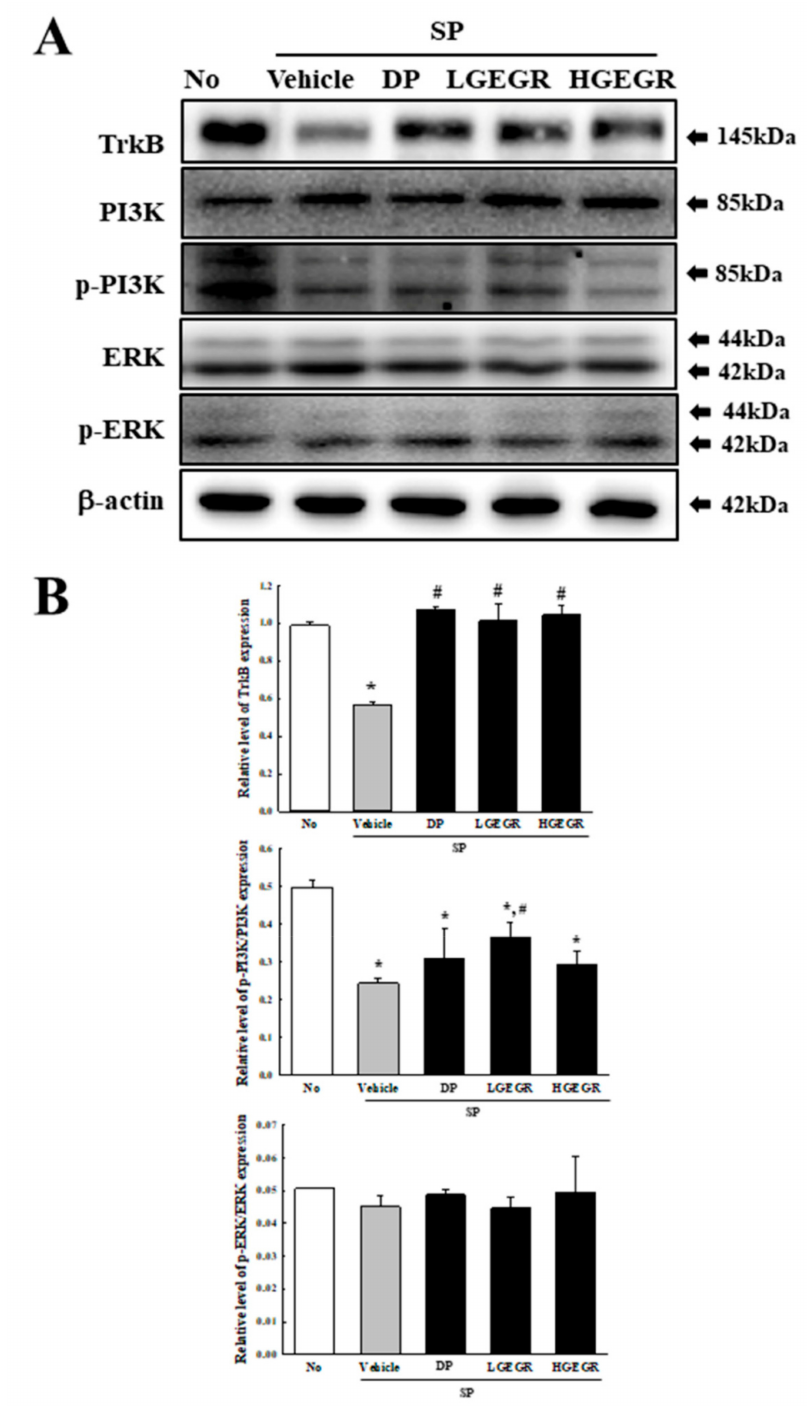
Figure 5. Alteration of the tropomyosin receptor kinase B (TrkB) receptor signaling pathway. Total tissue homogenates were prepared from the brain of Vehicle or GEGR treated SP-injected as described in Materials and Methods. Total protein (50 µ g per sample) was immunoblotted with TrkB, p-TrkB, PI3K, p-PI3K, ERK, p-ERK, or β -actin antibodies. The intensity of each band was determined by using an imaging densitometer, and the relative levels of the proteins were based on the intensity of actin. Three samples were assayed in duplicate by western blotting. Data are reported as mean ± SD values. * p < 0.05 compared with the No treated group. # p < 0.05 compared with the SP + Vehicle treated group. Abbreviation: DP, donepezil; GEGR, gallotannin-enriched extract of Galla Rhois; SP,